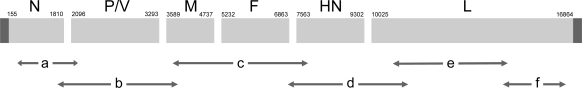
Schematic illustration of the HIPV4 genome and the relative positions of the amplicons obtained by long RT-PCR that were used in sequencing the SKPIV4 genome.